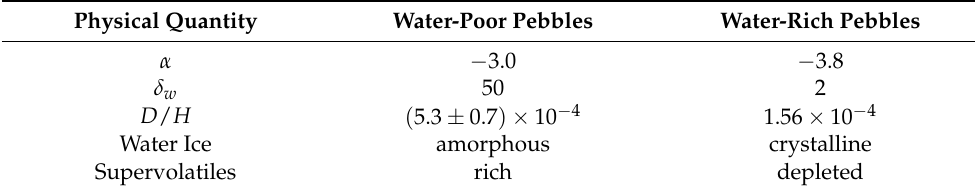
Table 3. Pebble parameters